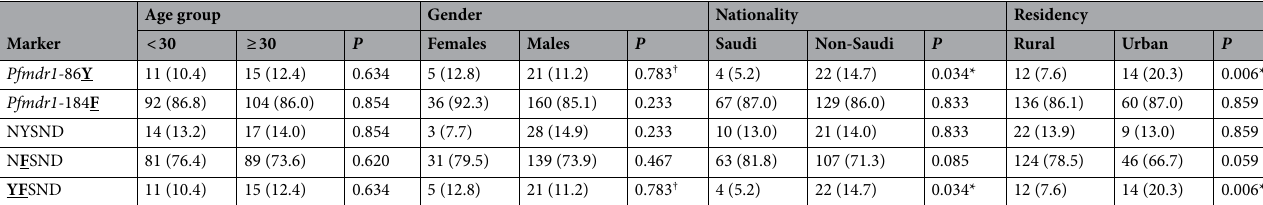
Table 3. Associations of pfmdr1 mutant alleles and related haplotypes detected in P. falciparum isolates from Jazan region with patients’ demographic factors (n = 227). Mutant alleles are bold and underlined. All values are number (%). Pfmdr1 -1034, Pfmdr1 -1042 and Pfmdr1 -1046 were of wild type and thus, not included in the analysis. *Significant association ( P < 0.05). † The difference was examined using Fisher’s exact test (otherwise, Chi Square test was